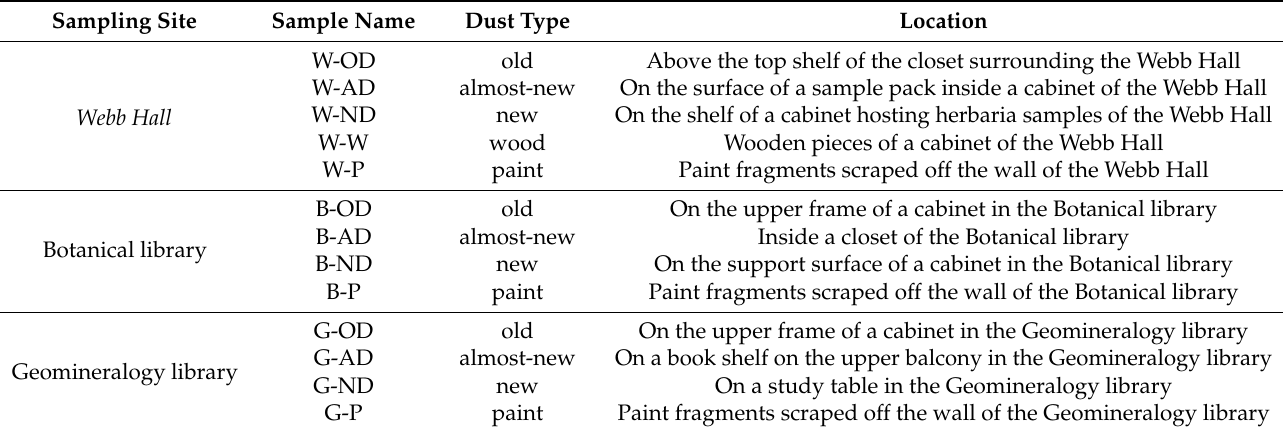
Table 1. Location and description of the sampling